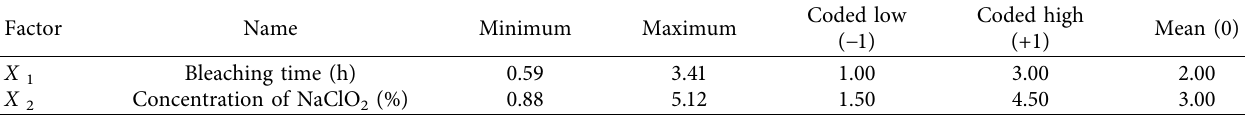
Table 1: Optimizing factors for bleaching on OPEFB.